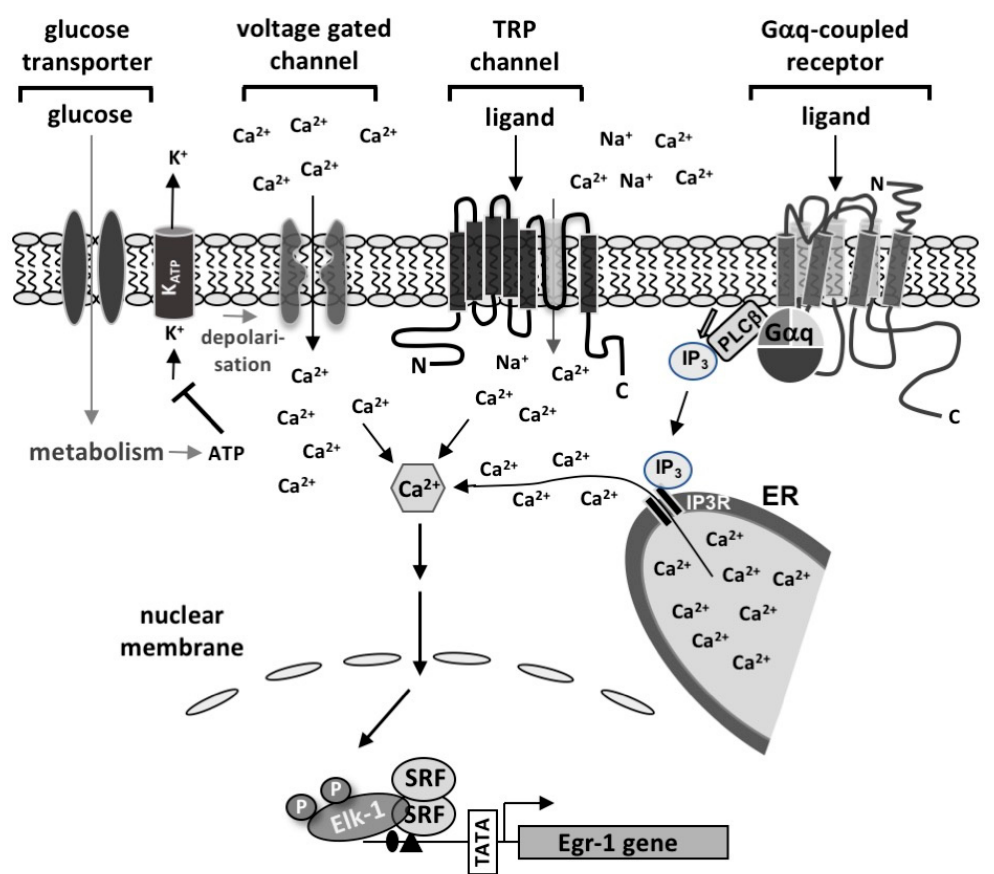
Figure 1. Cell surface receptors, channels, and transporters induce the phosphorylation of Elk-1 and the biosynthesis of Egr-1 in pancreatic β -cells. β -cells express numerous Ca 2+ channels at the plasma membrane, i.e., transient receptor potential (TRP) channels and voltage-gated Ca 2+ channels, which allow an influx of Ca 2+ ions. Stimulation of G α q-coupled receptors, such as M 3 muscarinic acetylcholine receptors, increases the intracellular Ca 2+ concentration via activation of phospholipase C β and the subsequent generation of inositol-1,4,5-trisphosphate (IP 3 ). Glucose that enters the β -cells via glucose transporter is metabolized in the cells, resulting in increased ATP concentrations. ATP triggers a shut-down of nucleotide-responsive K + channels. Subsequent depolarization of the plasma membrane leads to the activation of voltage-gated Ca 2+ channels and an influx of Ca 2+ ions. The increase in intracellular Ca 2+ concentration is necessary for initiating stimulus-regulated insulin secretion. In addition, Ca 2+ ions induce phosphorylation of Elk-1 and biosynthesis of Egr-1.